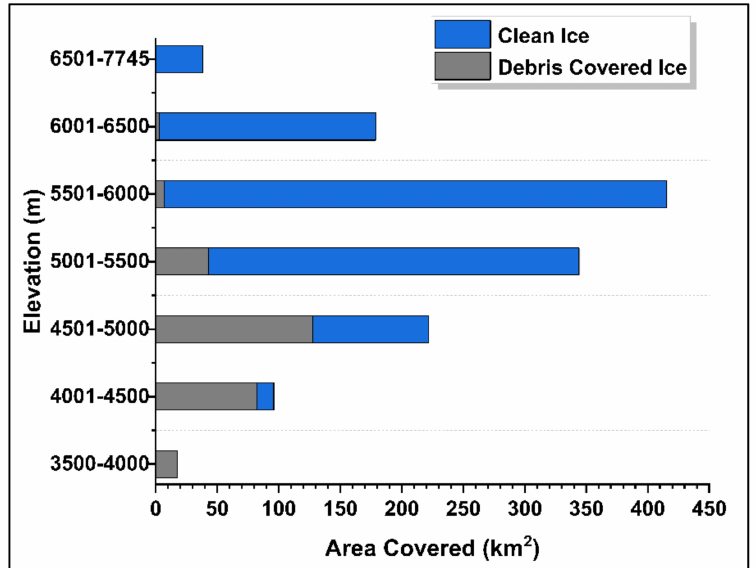
Figure 12. Distribution of ice and debris on different